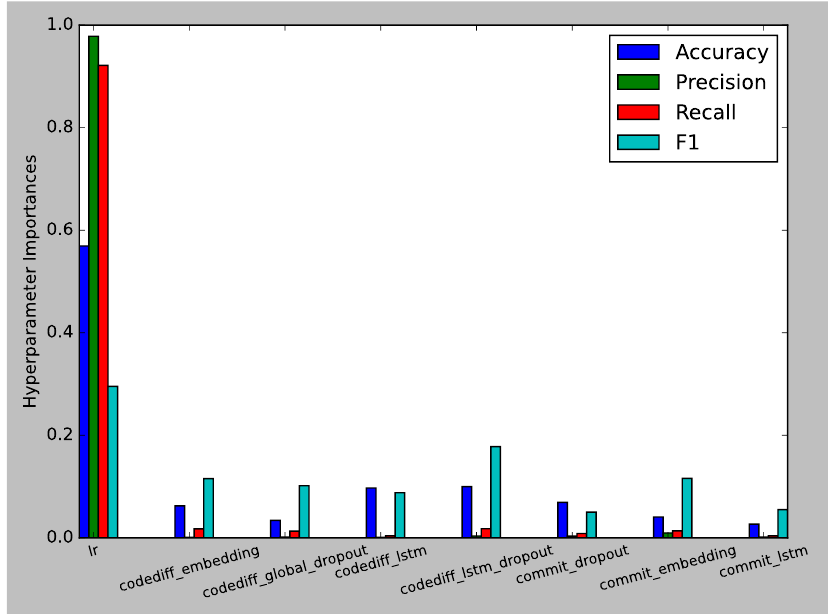
Figure 6. The importance of hyperparameters to evaluation